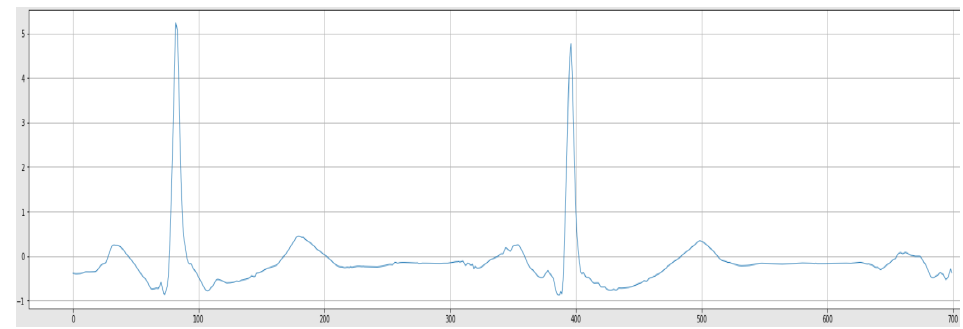
Figure 7. Class distribution ( a ) before resampling and ( b ) after resampling in the dataset D2.